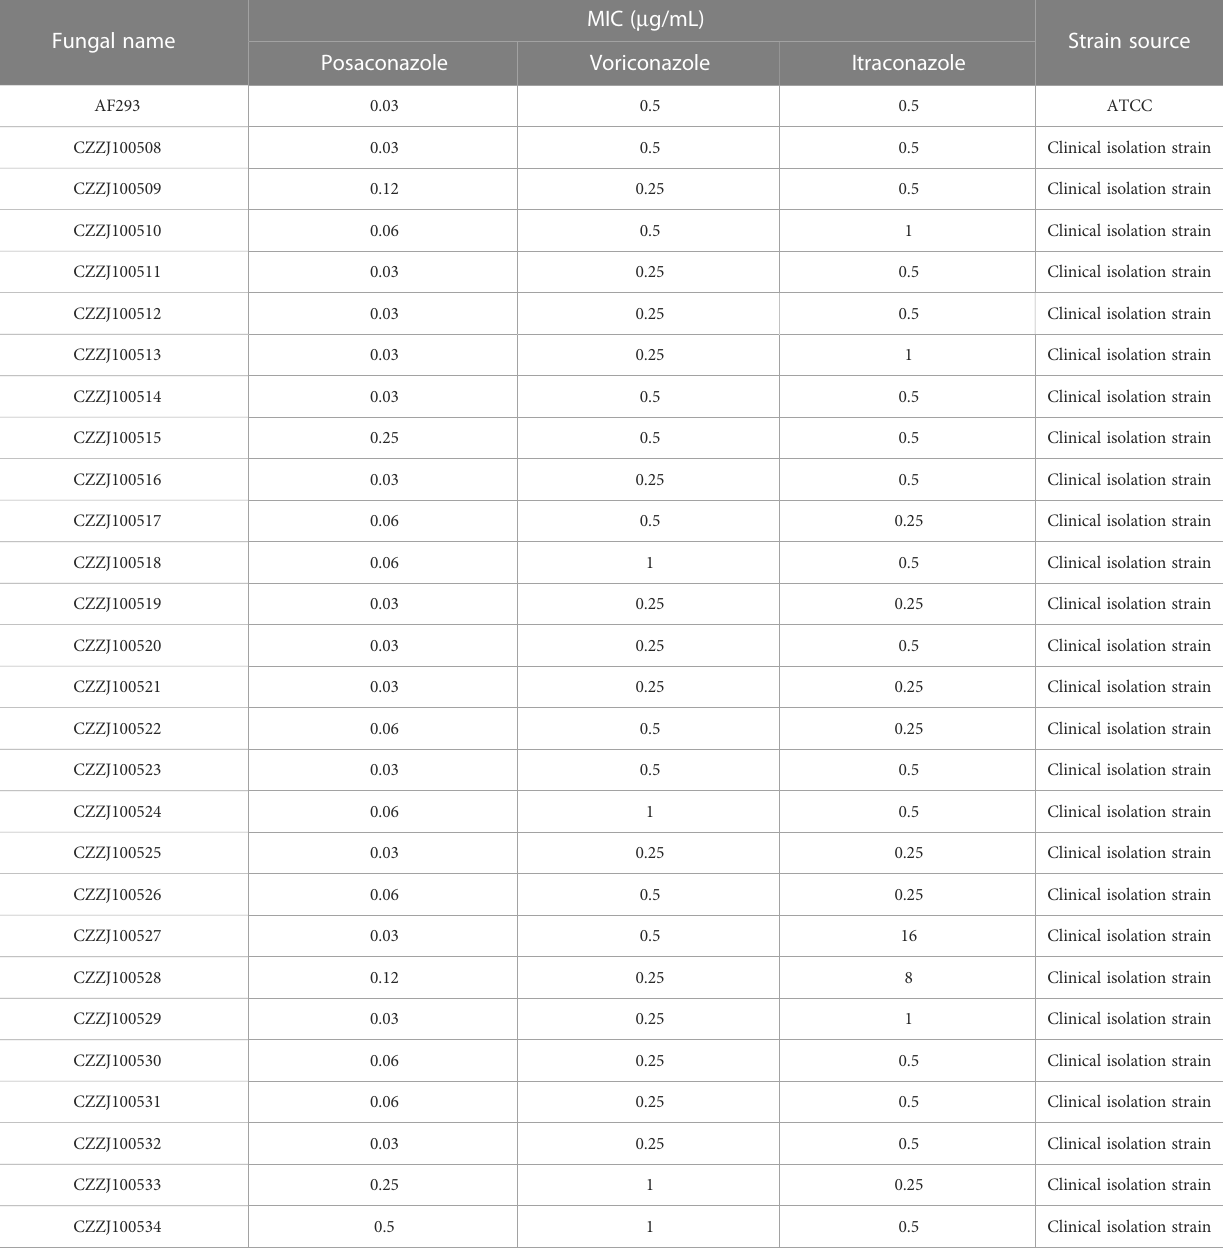
TABLE 1 Antifungal susceptibility testing results of Aspergillus fumigatus.